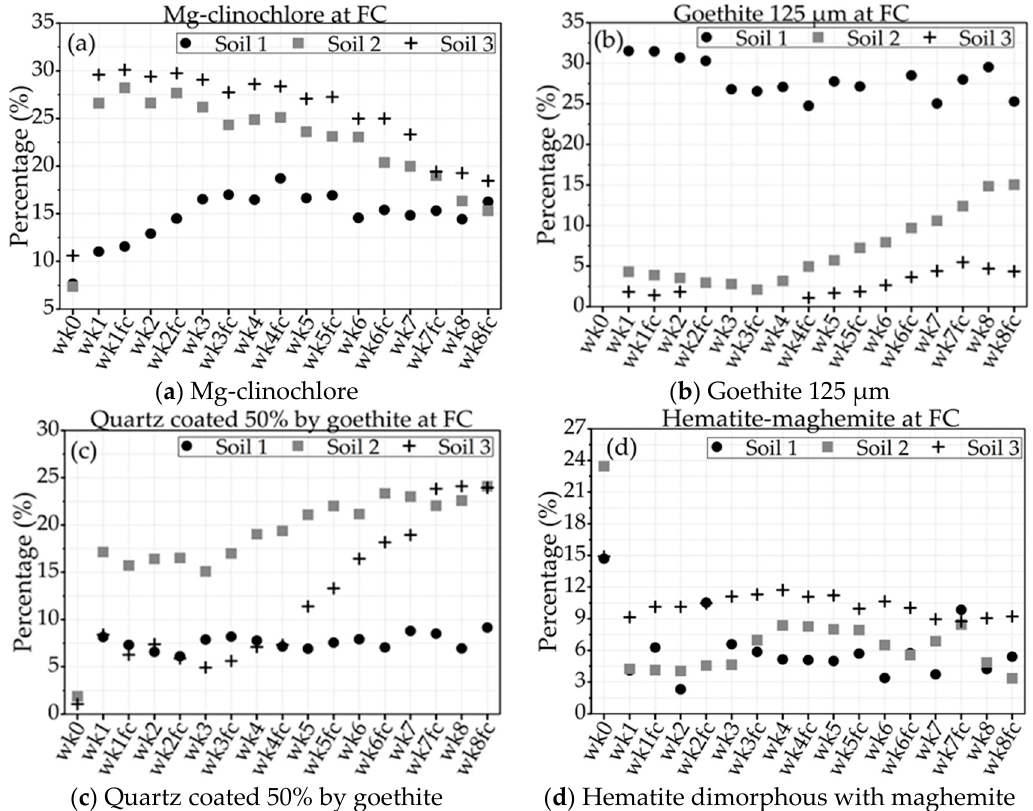
Figure 7. The average percentage of Mg-clinochlore ( a ), goethite 125 µ m ( b ), quartz coated 50% by goethite ( c ) and hematite dimorphous with maghemite ( d ) changes for all the soils at the FC treatment. The circle, square and plus symbols represent Soil 1, Soil 2 and Soil 3, respectively. The vertical axis characterizes the percentage of each mineral occurring in an image. The scale of the Y-axis varies from 0% to 100%. In the horizontal axis, wk1, ..., wk8 stands for week 1, ..., week 8. Since the experiment was performed every three days, wk1fc, ..., wk8fc (week 1fc, ..., week 8fc) was also used to represent the results. Here, the soil samples were at the field capacity all the time.